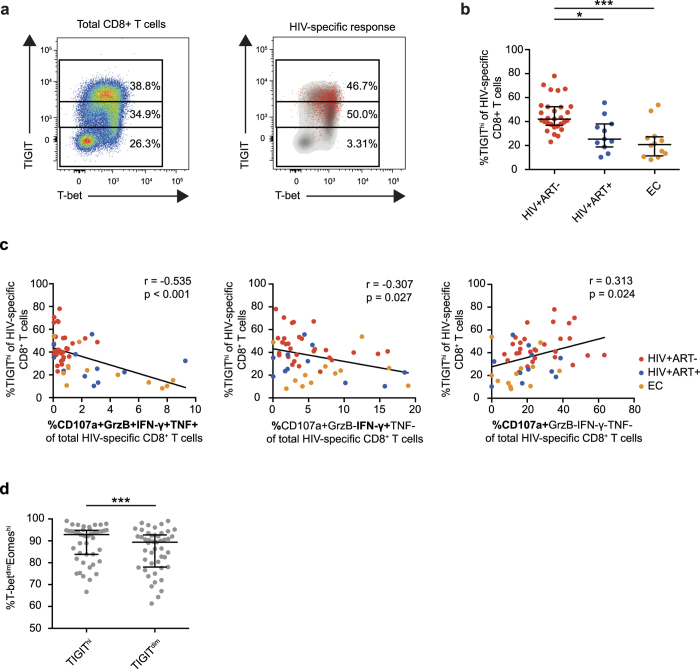
Functional capacity of HIV-specific CD8+TIGIThi cells (a) Gating procedure for TIGIThi, TIGITdim and TIGITneg cells on CD8+ T cells in a representative treatment naïve HIV infected subject. (b) Frequency of TIGIThi cells of HIV-specific CD8+ T cells in HIV-positive treatment-naïve (HIV+ART−, n = 28), HIV+ long-term treated (HIV+ART+, n = 18) and elite controller (EC, n = 11) subjects. (c) Correlation between the frequency of TIGIThi cells and the frequency of polyfunctional CD8+ T cells or single expression of IFN-γ and CD107a on HIV-specific CD8+ T cells in HIV+ART− (red, n = 28), HIV+ART+ (blue, n = 18) and EC (orange, n = 11) subjects. (d) Frequency of T-betdimEomeshi cells in the HIV-specific TIGIThi and TIGITdim population in HIV+ART− (n = 28), HIV+ART+ (n = 18) and EC (n = 11) subjects. One-way ANOVA followed by Kruskall-Wallis test and Dunn’s multiple comparisons test was used to compare between ≥3 groups. The Spearman non-parametric test was used for correlation analysis. The Wilcoxon matched-pairs signed rank test was used to compare paired samples. *P < 0.05 and ***P < 0.001.